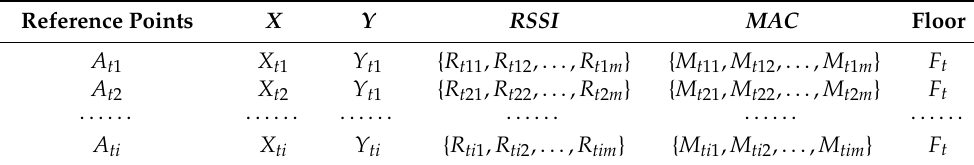
Table 1. Organization of the fingerprint database.